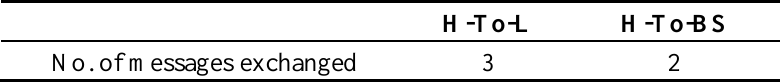
Table 4. Communication cost for H-To-L and H-To-BS